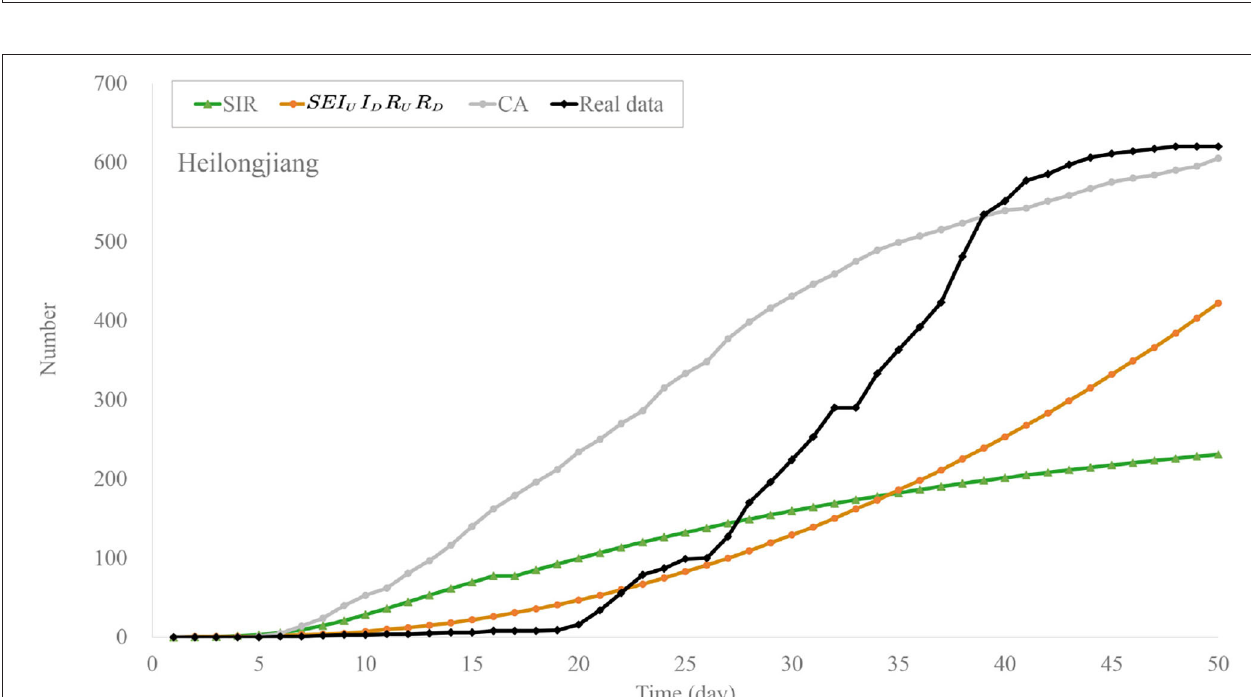
FIGURE 6 | Trend chart of recovered cases of the models in Heilongjiang province.